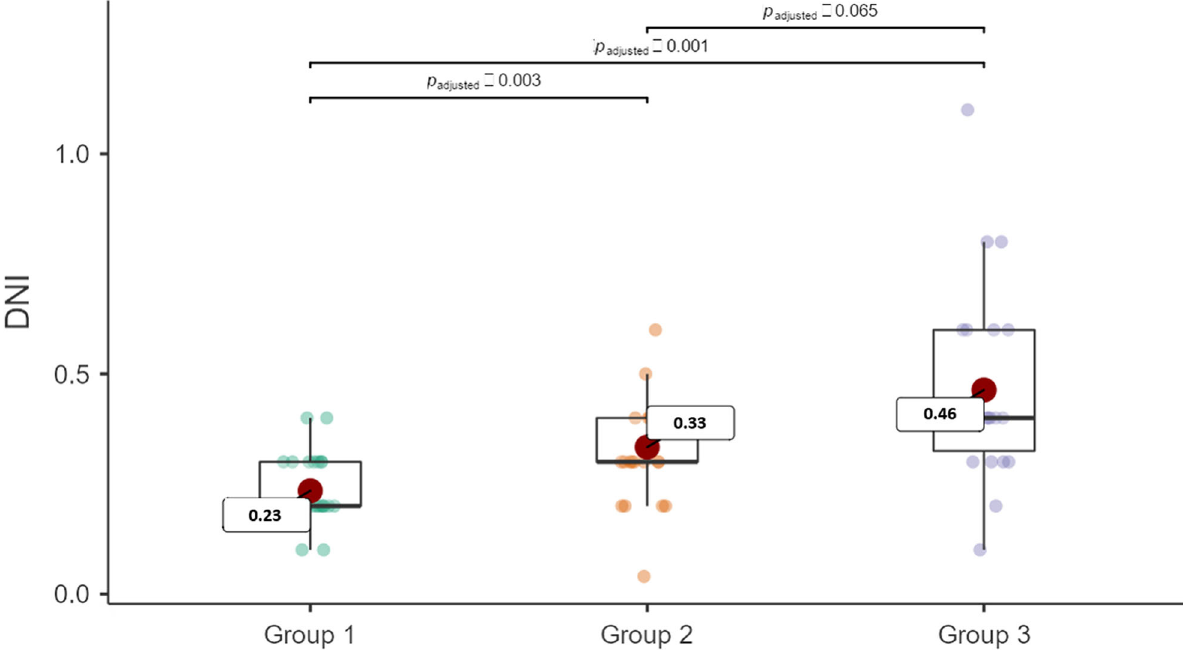
Figure 1- Intergroup difference in DNI